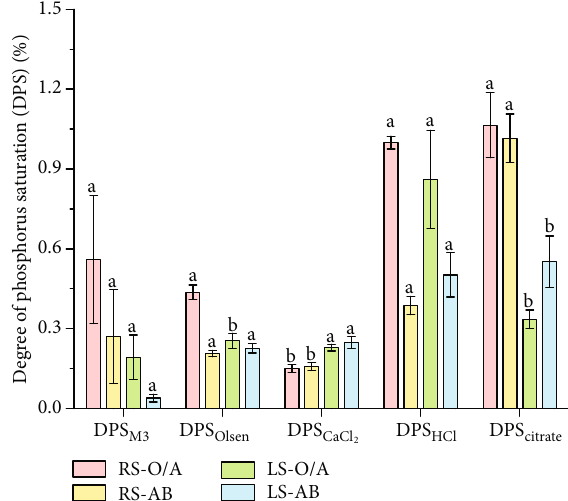
Figure 2: Distribution of extractable P in the bulk soils of O/A and AB horizons of red soil (RS) and limestone soil (LS). Di ff erent lowercase letters indicate signi fi cant di ff erences ( p < 0 : 05 ) among the P fractions from the same horizon of the same soil; di ff erent uppercase letters indicate signi fi cant di ff erences ( p < 0 : 05 ) of the same P fractions between the same horizon of the red soil and limestone soil. Error bars are standard error ( n = 3 ).